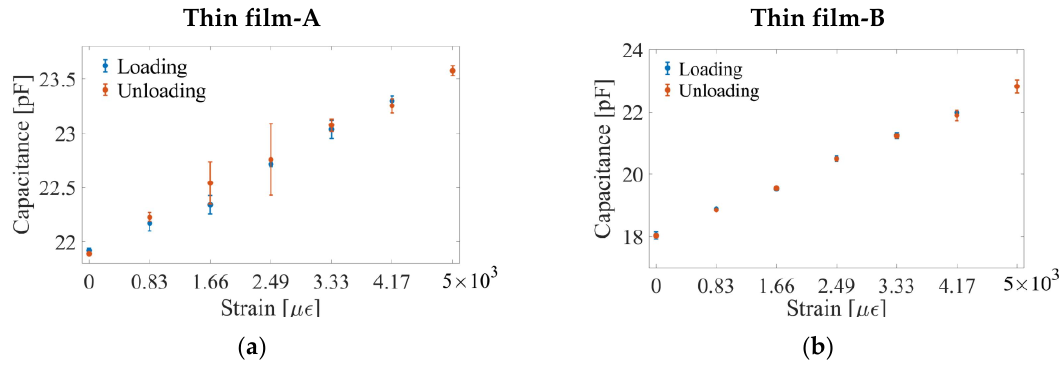
Figure 10. The capacitance of the film-contained parallel-plate capacitor during loading and unloading are shown for ( a ) Thin films-A and ( b ) -B. Standard deviations of measured capacitances are also shown (based on five specimens tested).